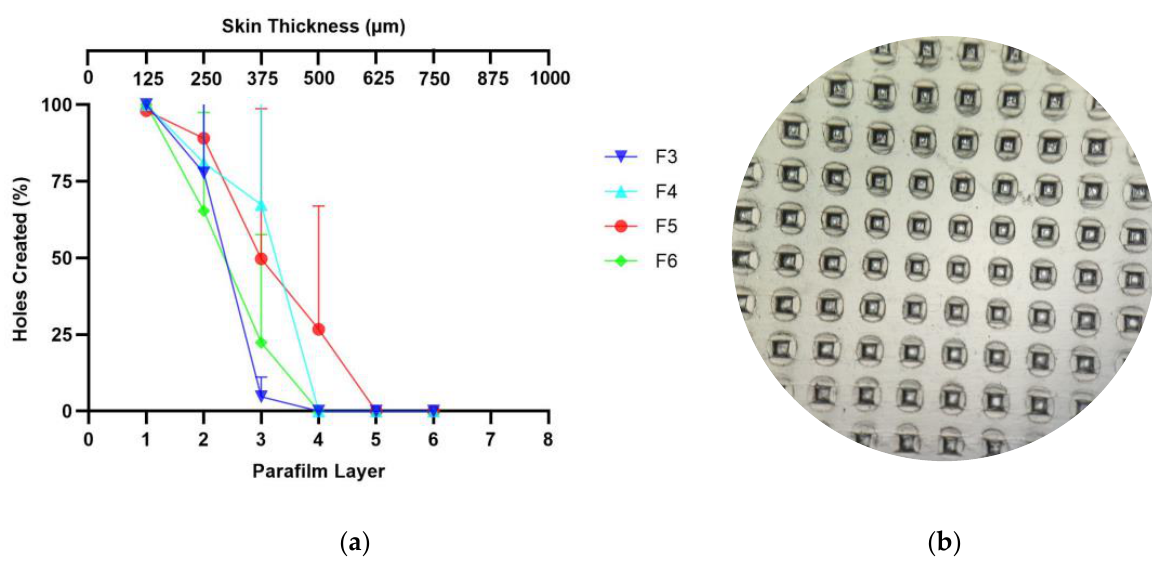
Figure 3. ( a ) Graph of the percentage of holes formed by each layer of parafilm. Data are represented as means + SD (n = 3). ( b ) The microscopic image of holes created on parafilm layer.